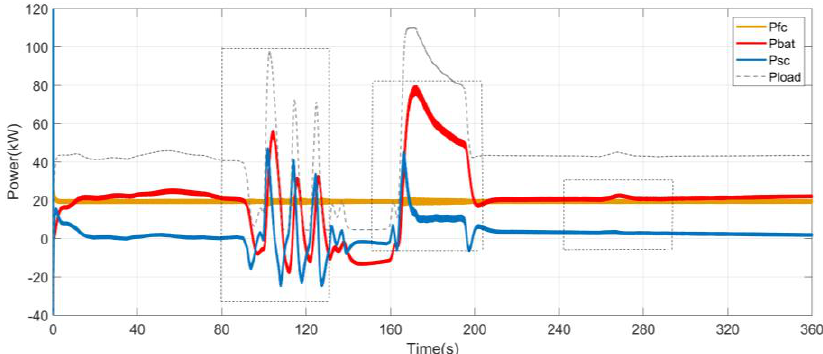
Figure 17. Power curve for a fixed filter time constant.